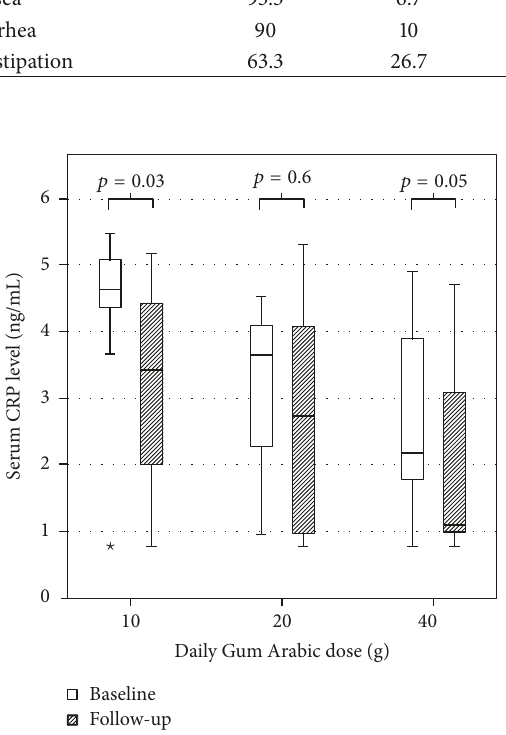
Figure 2: Baseline and follow-up C-reactive protein (CRP) values in different study groups. ⋆ An outlier in the data displayed by this